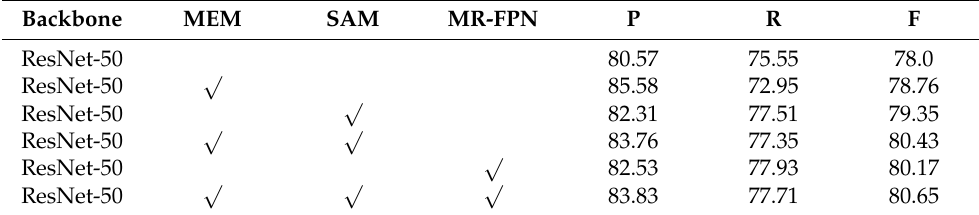
Table 1. Results under different modules; “P”, “R”, and “F”, respectively. represent precision, recall, and